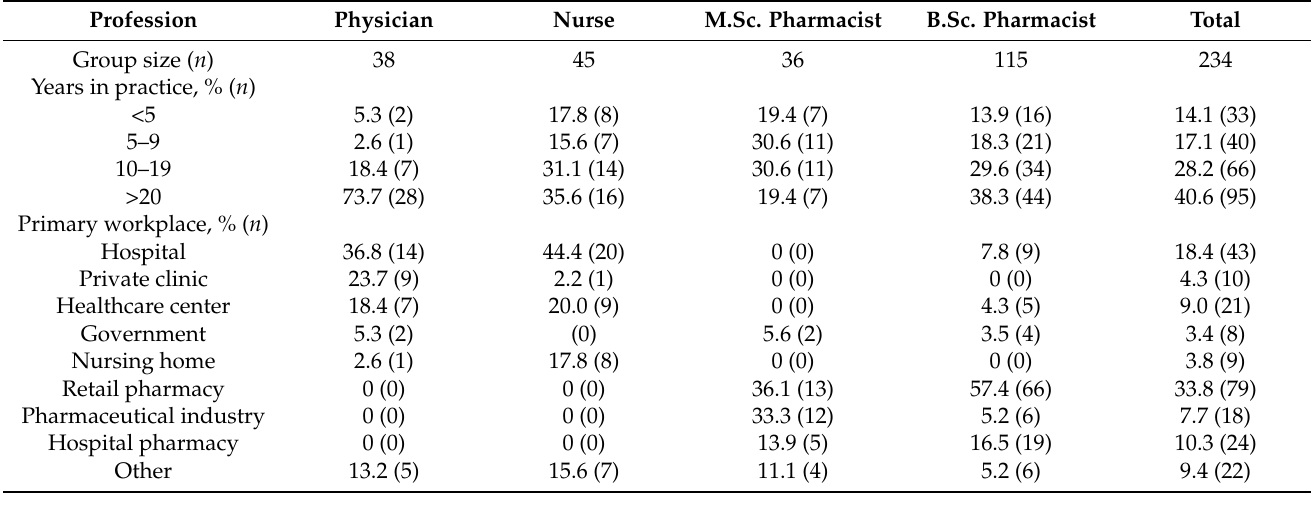
Table 1. Healthcare professional demographics.